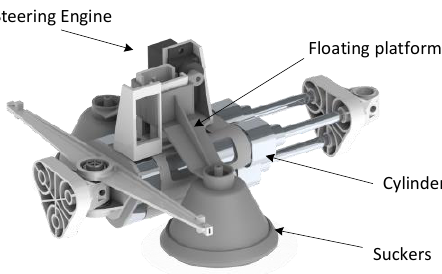
Figure 1. Skeleton structure unit of the first three segments of the robot. Each unit consists of three cylinders, a pair of pneumatic suckers, and a miniature motor.